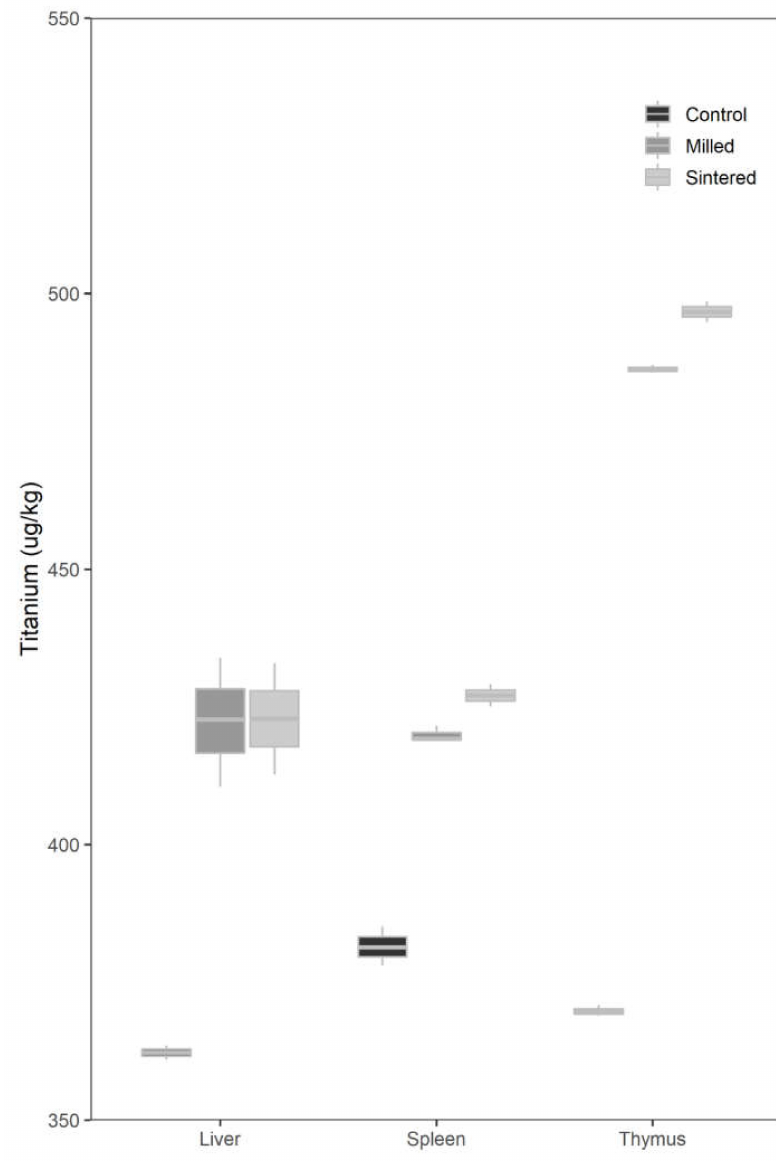
Figure 2. Box plot of organ titanium levels for the control and test